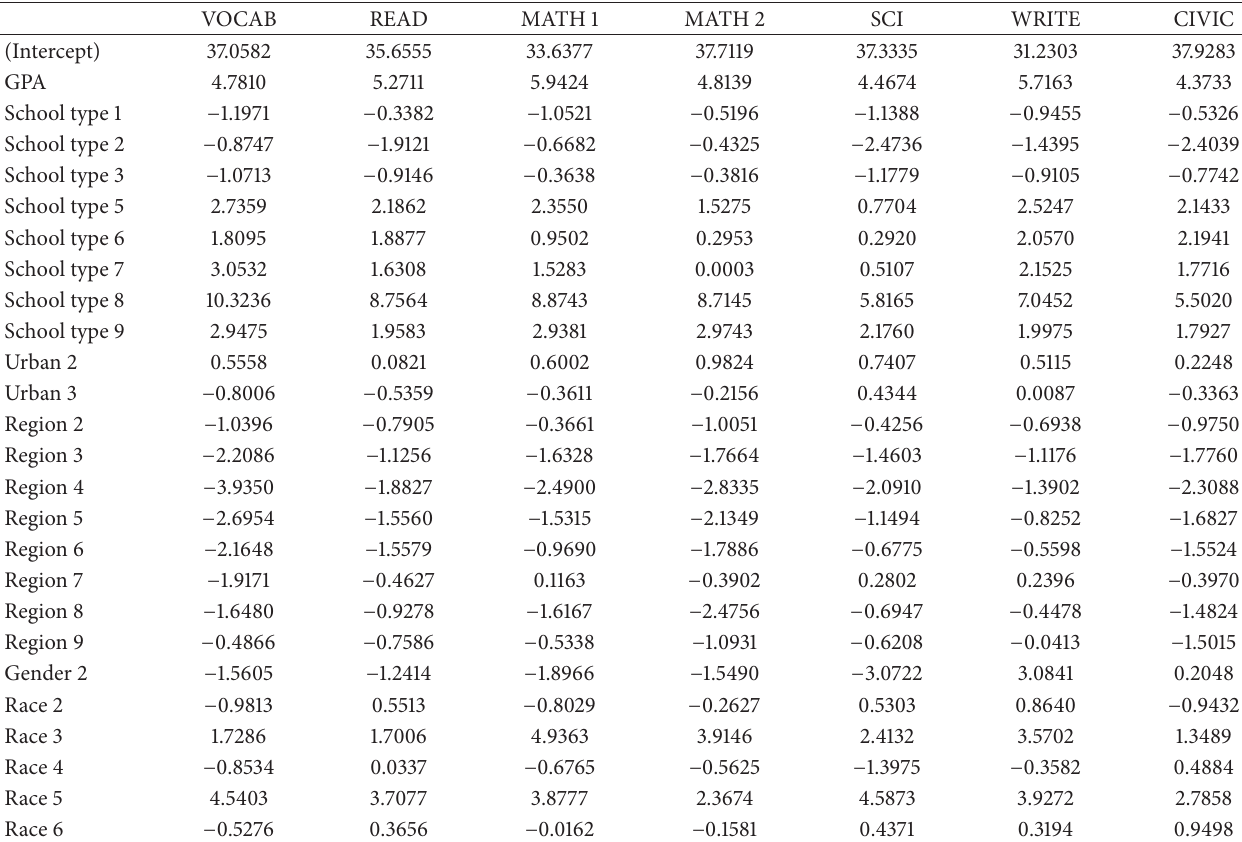
Table 2: Posterior mean for 𝛽